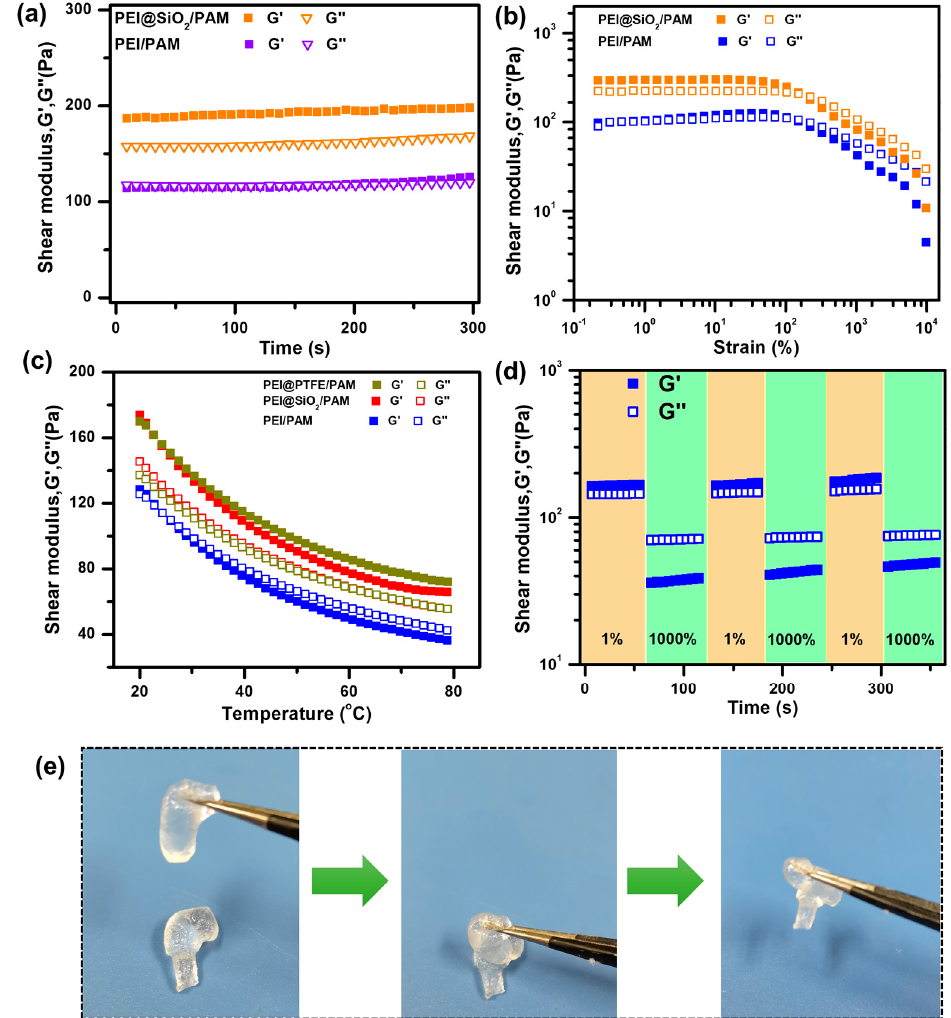
Figure 7. Rheology analyses of the PEI@HPs/PAM hydrogels. Storage modulus (G’) and loss modulus (G”) of ( a ) the hydrogel as a function of time at a fixed strain ( γ = 1%) and a fixed frequency (f = 1 Hz). ( b ) Strain amplitude sweep ( γ = 0.1~10,000%) at fixed frequency ( f = 1 Hz). ( c ) G’ and G” versus temperature ( T = 20~80 ◦ C) at a fixed strain ( γ = 1%) and a fixed frequency (f = 1 Hz). ( d ) G’ and G” versus time under alternated strain change cycles (1% → 1000% → 1%). ( e ) Photos